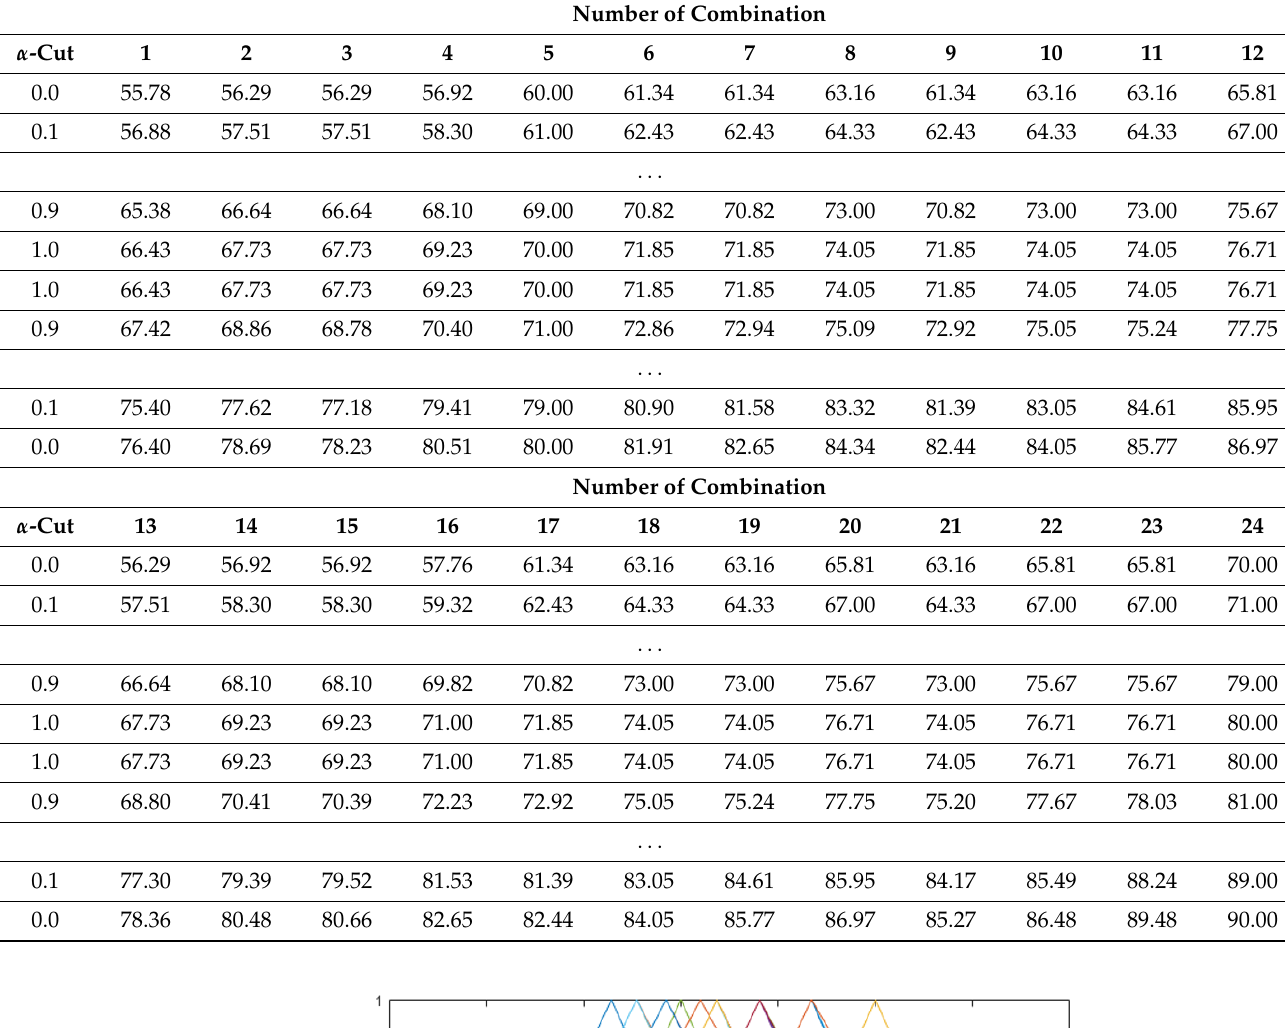
Table 8. The rating value of the superstructure component for all combinations (shortened version).